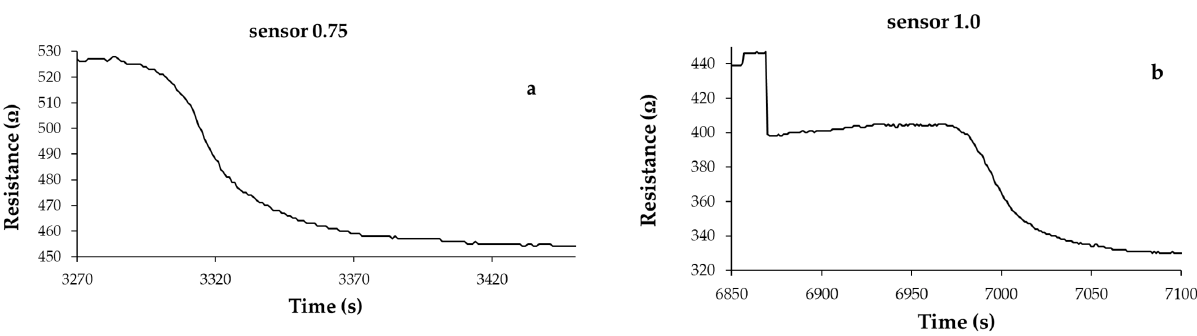
Figure 12. Recovery times of the resistive sensor after the second cycle; the recovery time was measured from 100% to 0% RH (clean, dry nitrogen): ( a ) sensor 0.75 and ( b ) sensor 1.0.